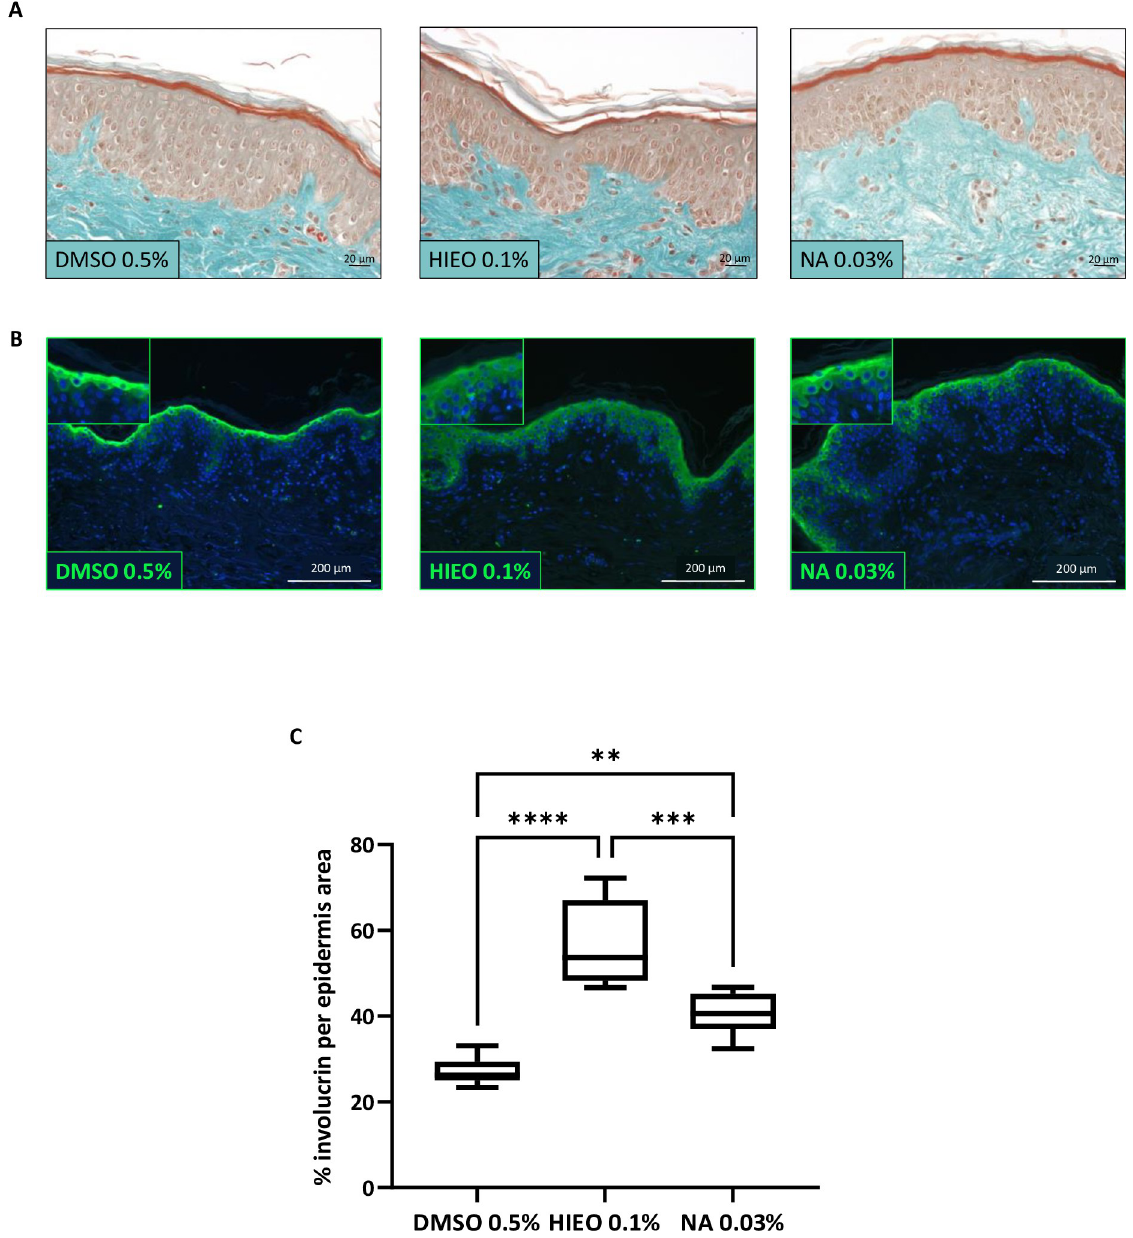
Fig 6. NA increased IVL protein. A: Histological and morphological analysis at day 5 using Masson’s trichrome staining after application of DMSO 0.5%, HIEO 0.1% or NA 0.03%. Scale bar, 20 μ m. B: Confocal microscopy observation of IVL immunostaining. Scale bare, 200 μ m. IVL in green, nuclei in blue. C: Quantification of IVL surface area by image analysis. Data are expressed in % IVL per epidermis area. IVL data are presented as box and whisker plot where boxes span first and third quartiles, bars as the median values, and whiskers as the minimum and maximum mean of five representative images per replicate (n = 4). �� p < 0.01; ��� p < 0.001; ���� p < 0.0001 (Mann–Whitney